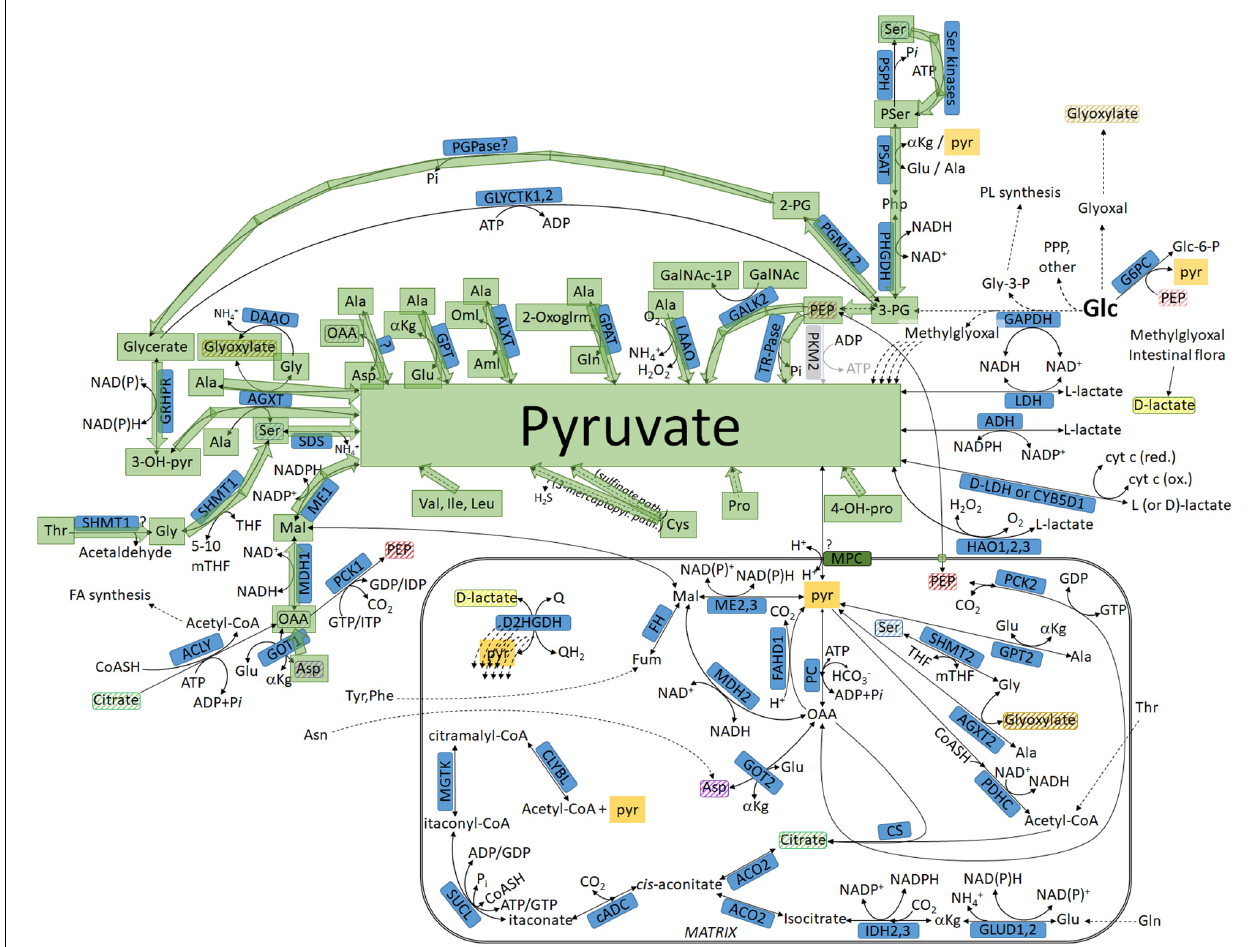
FIGURE 4 | Pathways leading to pyruvate but not commencing from glucose, highlighted in green: intermediates not transiting through the mitochondria. For abbreviations, see Table 1